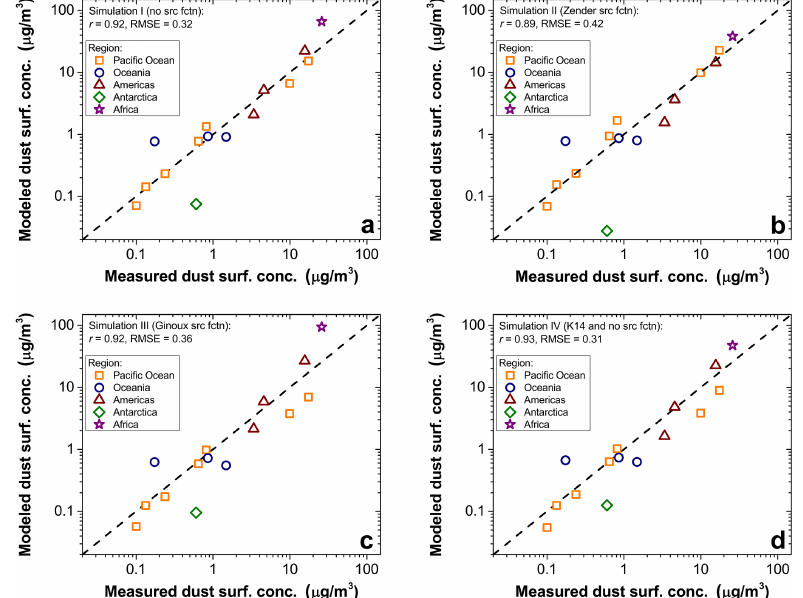
Figure 7. Comparison of the annually-averaged modeled dust surface concentration with that measured at 15 stations (see Sect. 2.3.1). Results are shown for (a) simulation I (no source function), (b) simulation II (Zender et al. (2003b) source function), (c) simulation III (Ginoux et al. (2001) source function), and (d) simulation IV (no source function, and dust flux is parameterized following K14 instead of Z03). For each panel, the RMSE and r in log10-space are noted.